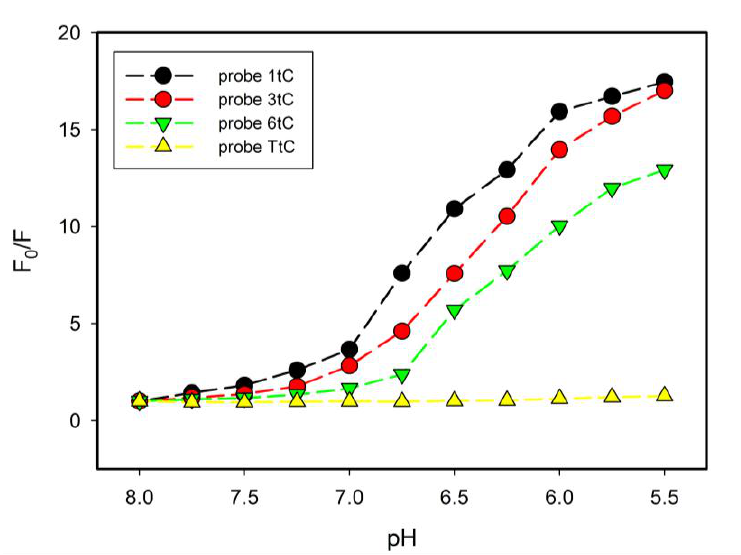
Figure 5. The dependence of fluorescence quenching (F 0 /F) vs. pH for 1tC (black circles), 3tC (red circles), 6tC probes (green triangles down) and TtC (yellow triangles up). F 0 (at